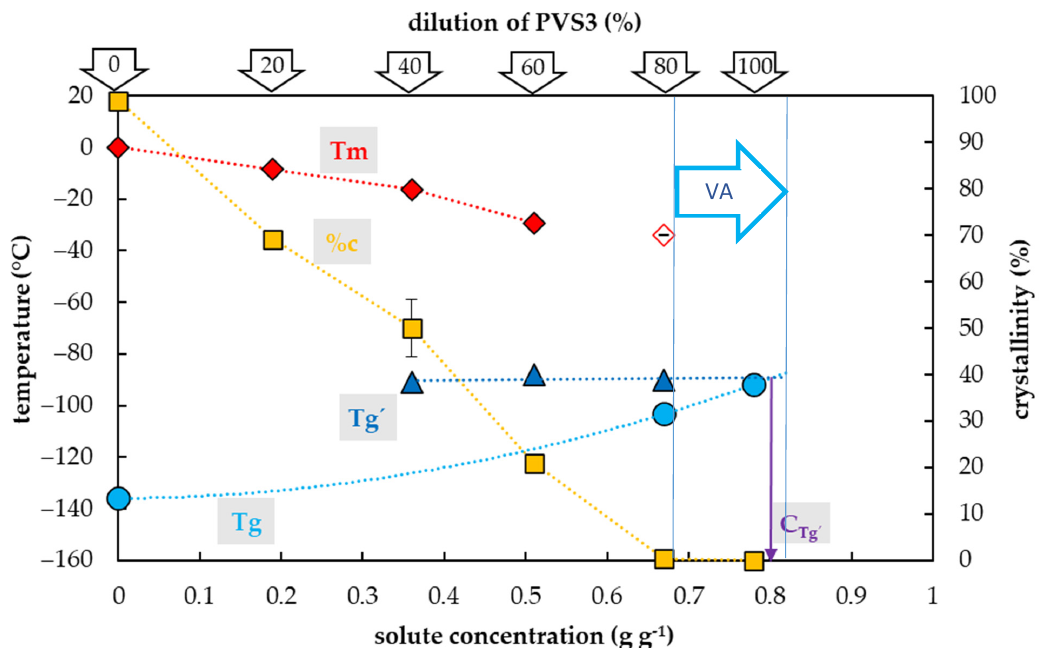
Figure 2. Thermal characteristics of osmotic components of the Plant Vitrification Solution 3 (PVS3) depending on their concentrations in aqueous solution. The total concentration of solutes is expressed as the mass of solutes (g) per mass of aqueous solution (g). The left y -axis indicates the temperature of thermal events, the right y -axis shows the percentage of water crystallinity based on the total mass of solution. The temperature of the glass transition (Tg) of the solution is indicated by a cyan circle, the Tg’ originating from freeze-concentrated solution during the cooling period is indicated by a blue triangle, the onset of the water melting peaks (Tm) is indicated by a red diamond if the effect occurs during the cooling period, the onset of the water melting peak is indicated by a hollow diamond if the effect occurs during the warming period. The percentage of water crystallinity (%c) based on the total mass of the solution is indicated by an orange square. The vitrification ability (VA) demonstrates the range of solute concentrations with the appropriate vitrification ability. Cg´ indicates a concentration of the freeze-concentrated solution. All effects were measured during the warming period of C/W cycles at a rate of 10 °C min − 1 . Results are presented as a mean of three repetitions and vertical bars represent standard error.